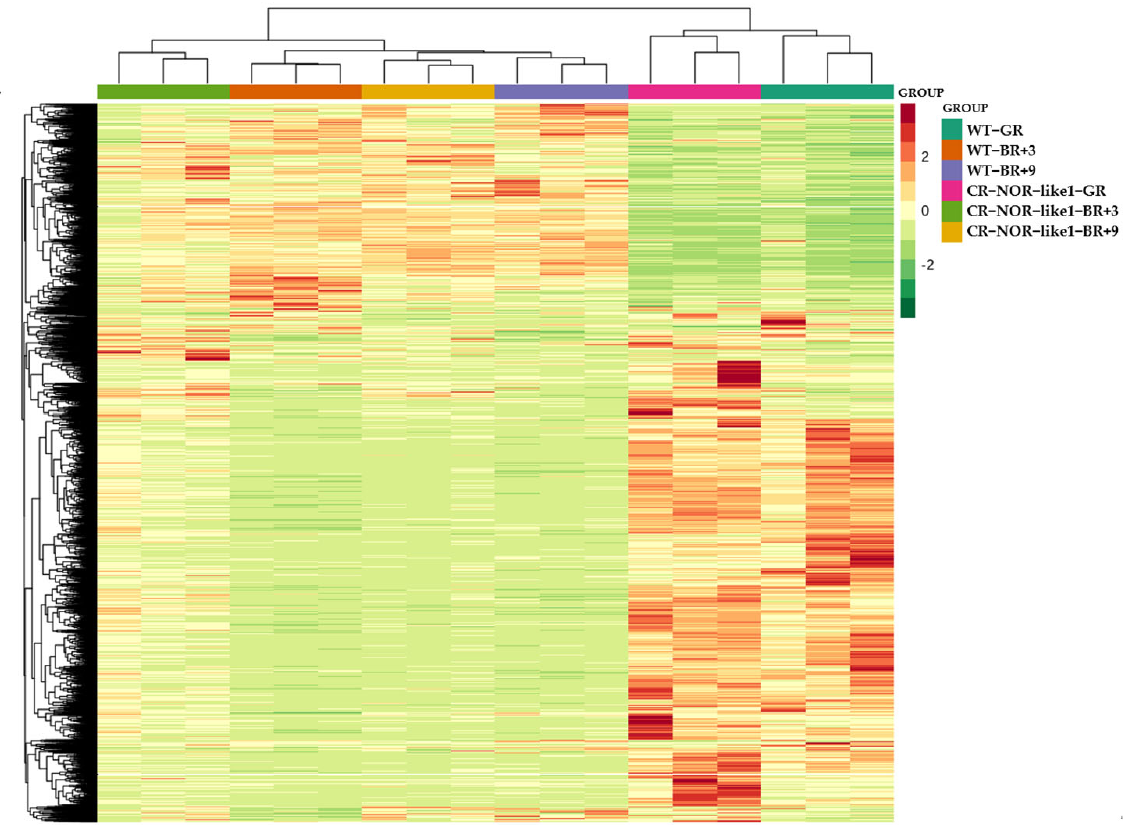
Figure 5. ( A ) The differentially expressed genes in the hierarchical clustering heat map; horizontal coordinates indicate sample names and hierarchical clustering results, and vertical coordinates in ‐ dicate differential genes and hierarchical clustering results. Red indicates high expression; green indicates low expression. ( B ) Numbers of differentially expressed genes.